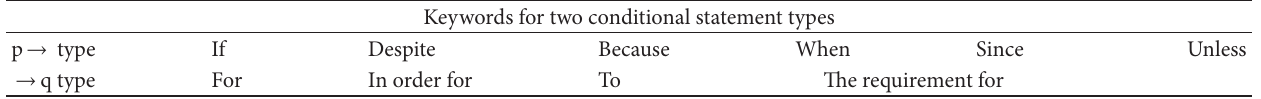
Table 3: Keywords for p → and → q type conditionals.